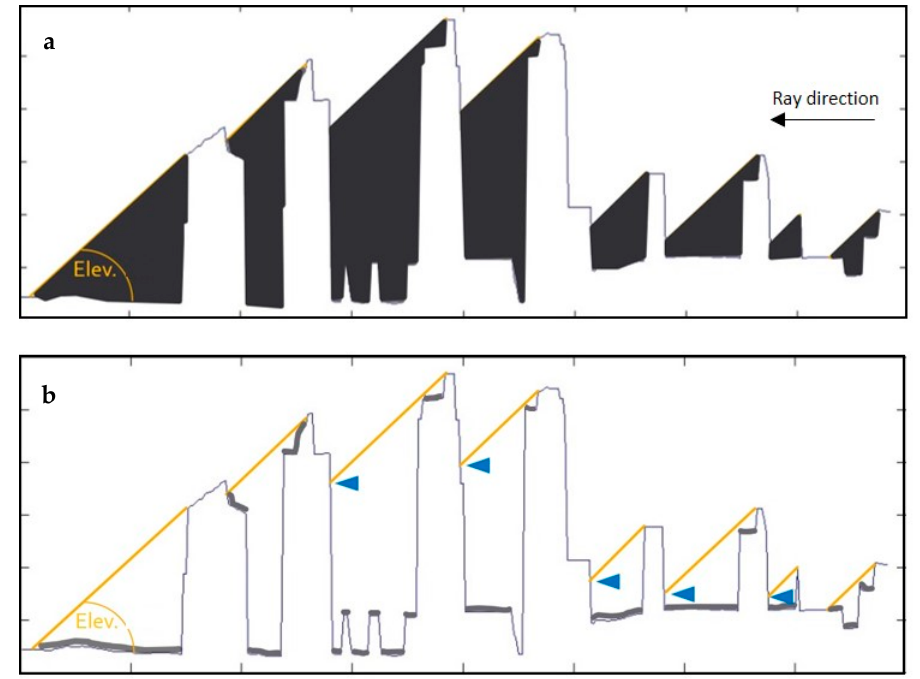
Figure 1. Shadow algorithm: progression of the ray limiting the height of the cast shadow ( a ); pixels of the digital surface model (DSM) in shadow (gray lines) and maximum shadow height in facades (blue arrows) ( b ).